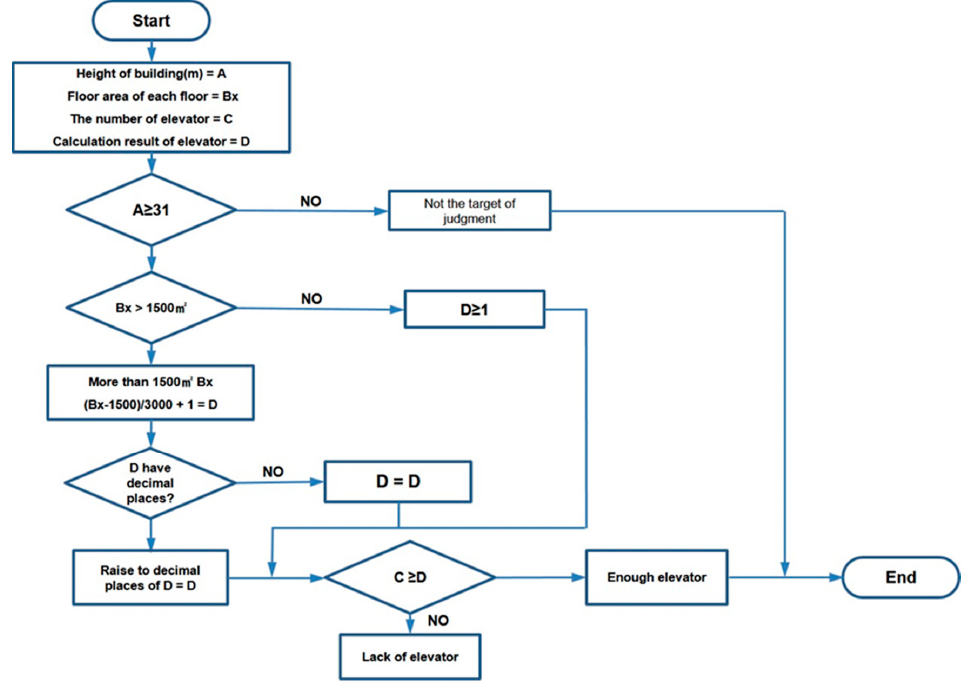
Figure 7. Flowchart for checking installation of elevator.